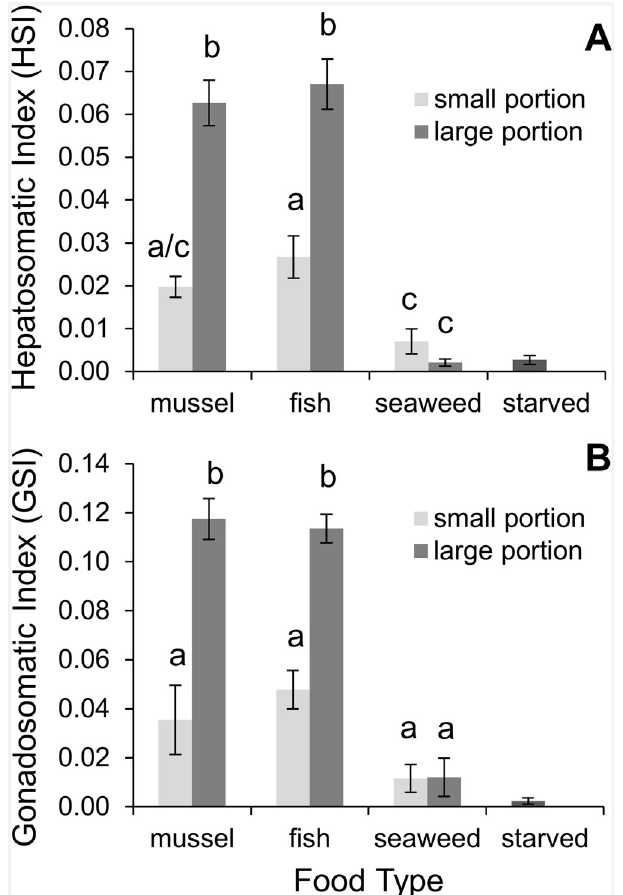
Fig 2. Effect of diet on tissue investment towards the hepatopancreas and reproduction. Mean ± SE A) Hepatosomatic Index (HSI) and B) gonadosomatic Index (GSI) of crabs fed either ribbed mussels ( Geukensia demissa ), fish ( Fundulus heteroclitus ), or seaweed ( Ulva lactuca ) at one of two portion sizes (large or small) for ~2.5 months (n = 10). For reference purposes, starved crabs were expressed in the figures as separate columns (n = 4). Starved crabs were not used in the statistical